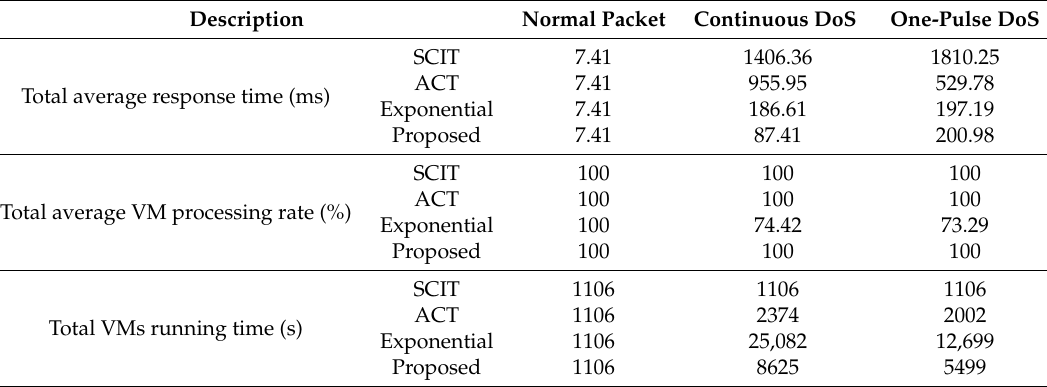
Table 2. Total average response time and VM processing rate and total VM running time in three scenarios. DoS: denial of service, SCIT: self-cleansing intrusion tolerance, ACT: adaptive cluster